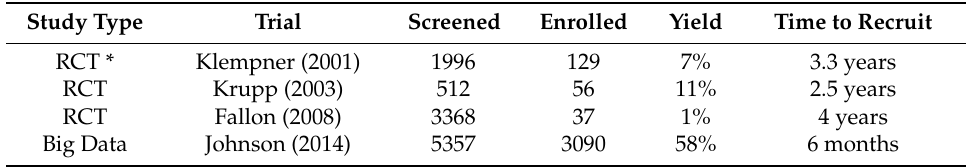
Table 4. Research trials for chronic Lyme disease are small and highly selective compared to patient-generated big data